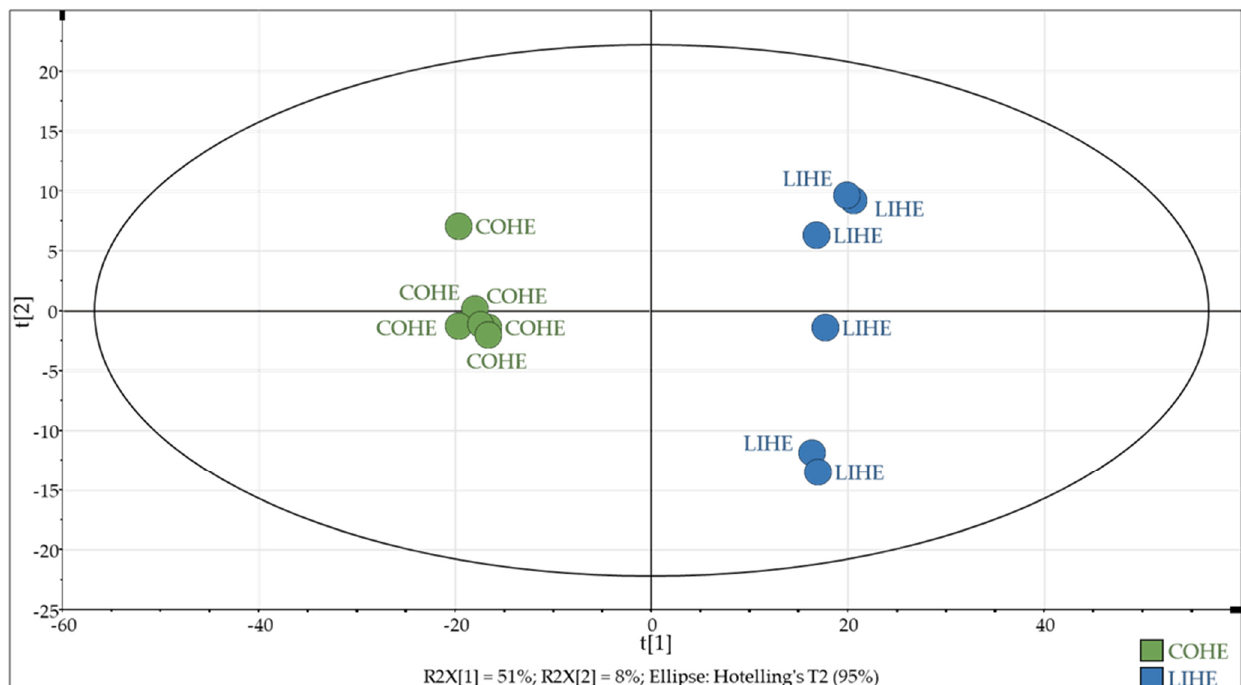
Figure 3. PCA performed on the 774 extracted BBHA-derivatized features. COHE: coconut oil supplemented with heme iron. LIHE: linseed oil supplemented with heme iron. Table 2. Lipid oxidation products and fatty acids identified at level 1 by the untargeted aldehydomics strategy. Compound m / z [M+H] + Rt (min) Identification Level FoldLIHE/COHE Malondialdehyde (MDA) 438.96519